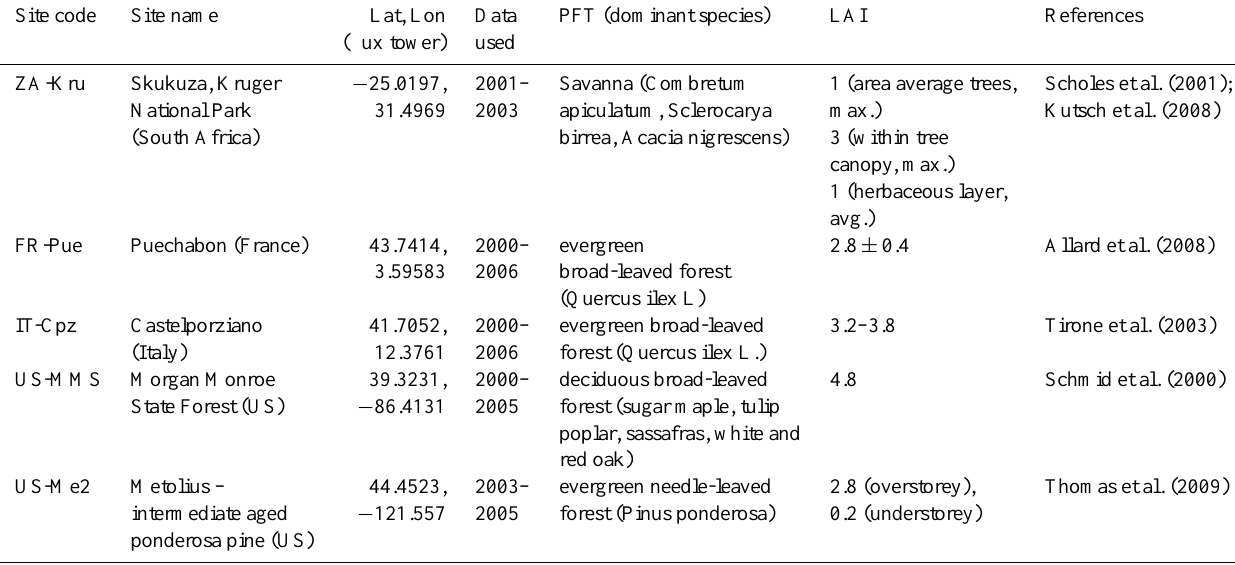
Table 1. Overview of the sites used in this